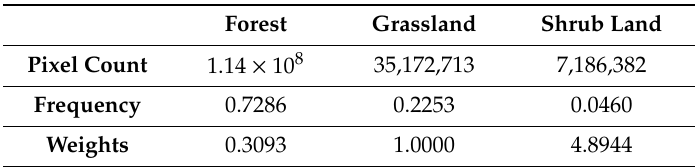
Table 7. Pixel numbers for the three classes, class frequency and median frequency class weights used in DeepLabV3 + training (Slovenia—3 classes).